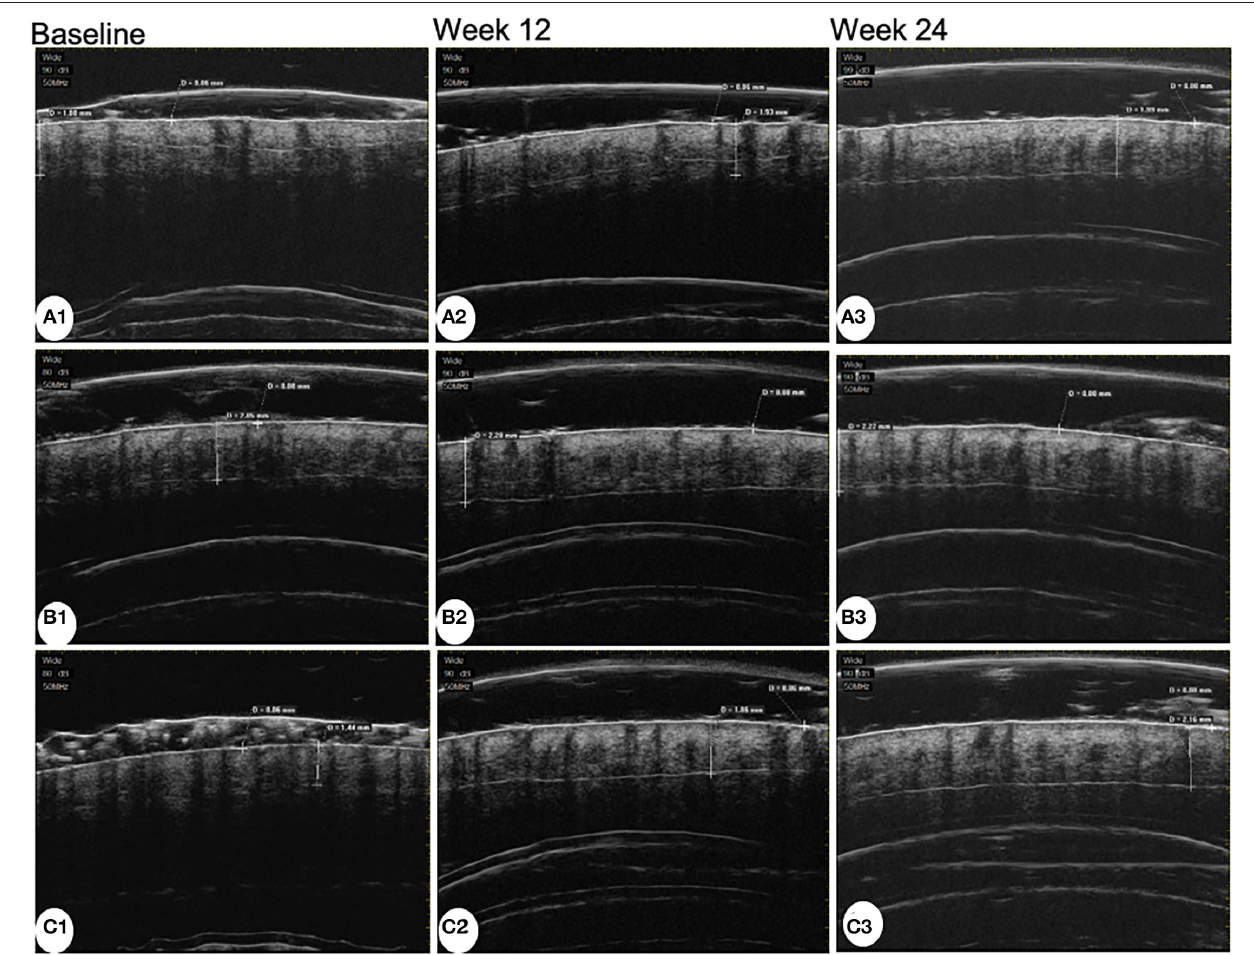
FIGURE 3 | Ultrasound biomicroscopy images of patients treated with minoxidil (A) , minoxidil plus spironolactone (B) , and minoxidil plus microneedling (C) at baseline, week 12, and week